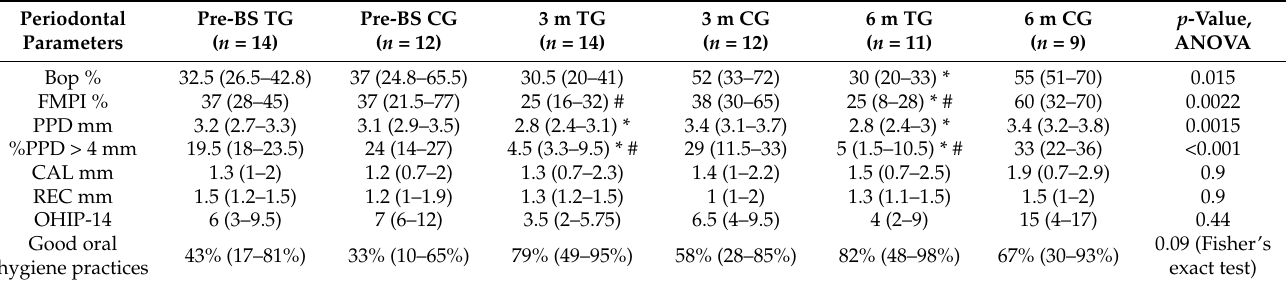
Table 3. Periodontal parameters before and after BS in test and control group.